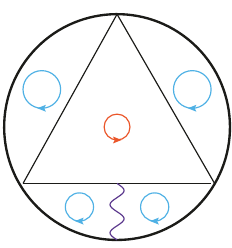
Figure 2. Cartoon of a diagram contributing to the latitude Wilson loop expectation value where the scalar triangle interacts with an insertion on the Wilson line. This forces powers of N 1